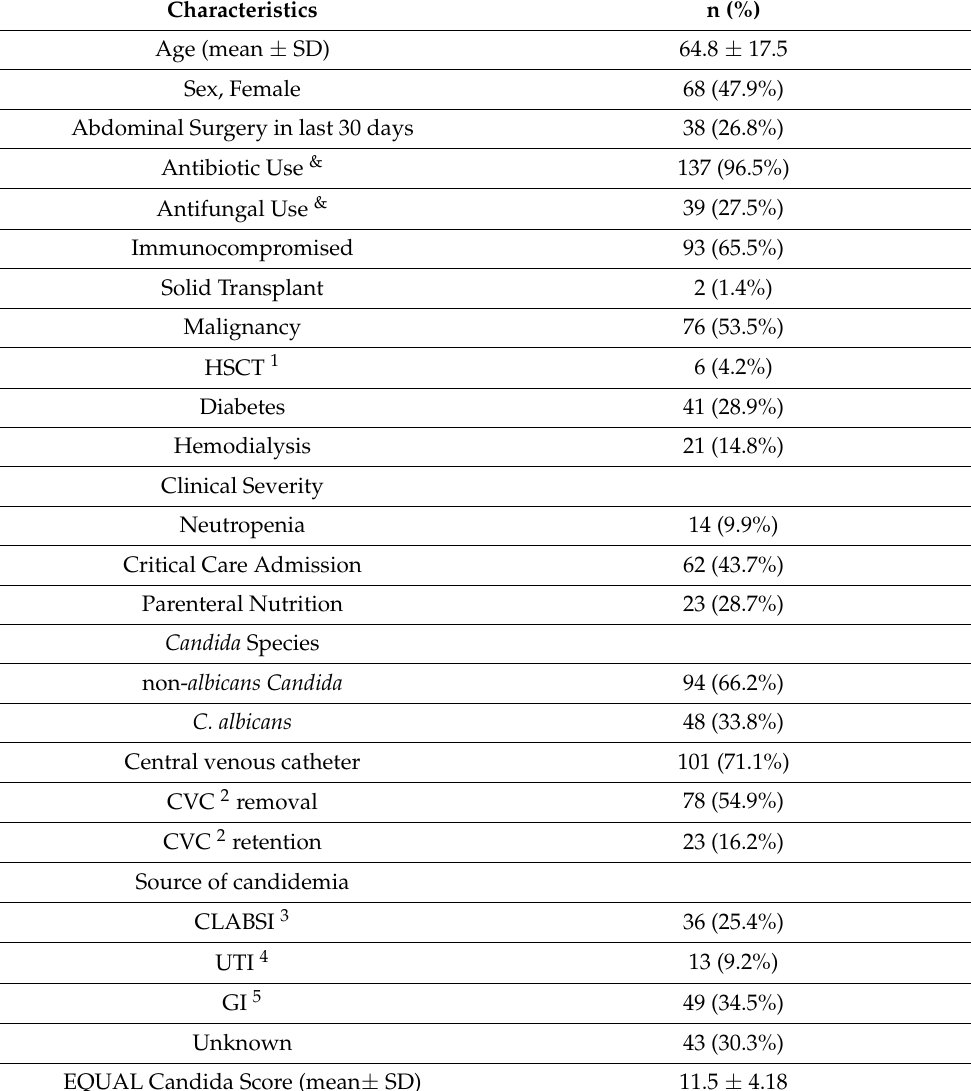
Table 2. Baseline characteristics of the enrolled